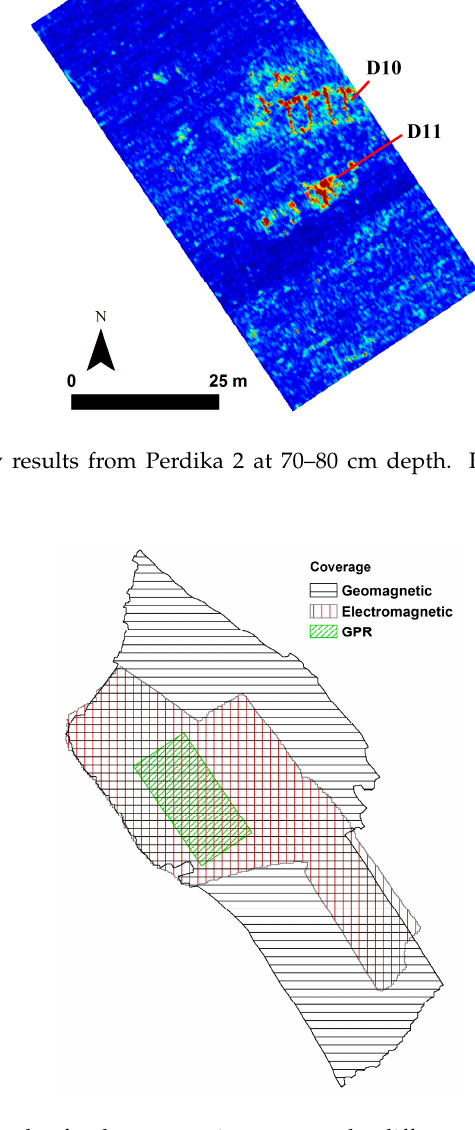
Figure 18. The overlay for the prospection coverage by different methods at Perdika 2.